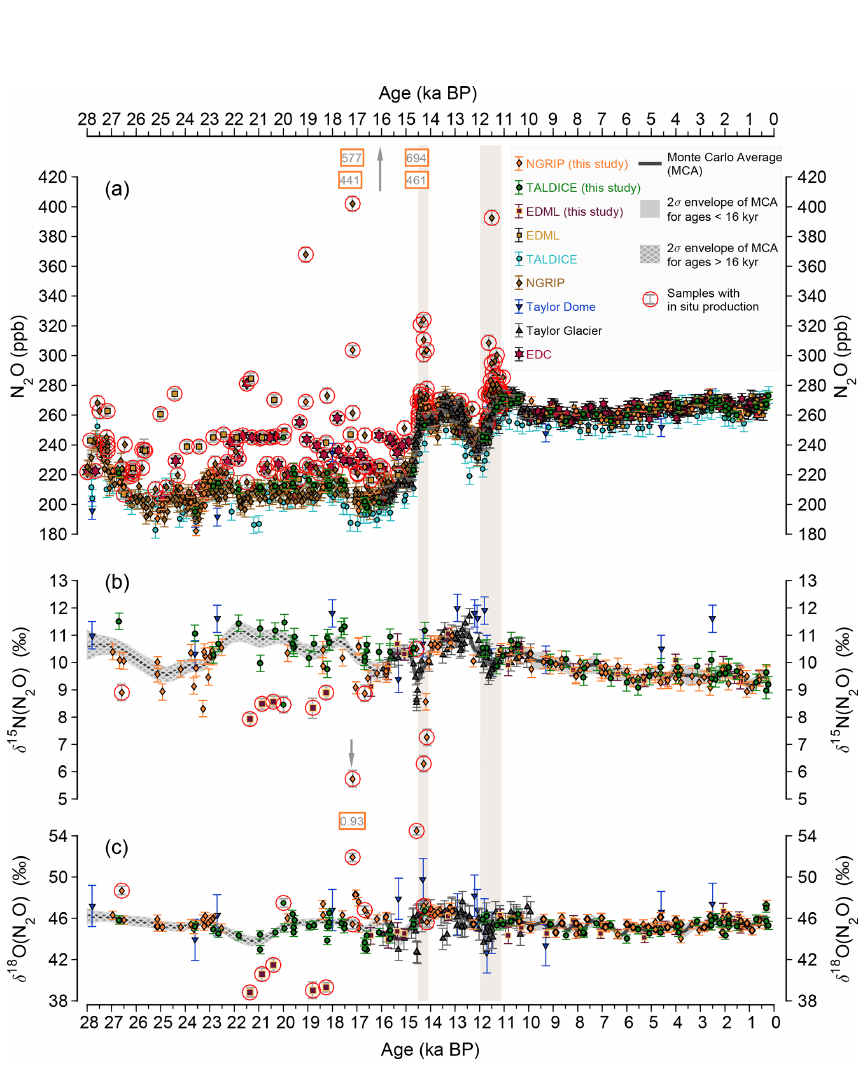
Figure 1. Compilation of new and published N 2 O records over the last 28kyr including identified artifacts due to in situ production of N 2 O. (a) N 2 O concentration from this study and published records (Sowers et al., 2003; Bernard et al., 2006; Flückiger et al., 2002; MacFarling Meure et al., 2006; Park et al., 2012; Schilt et al., 2010b; Schmitt et al., 2014) (b) δ 15 N(N 2 O) and (c) δ 18 O(N 2 O) from this study and published records (Sowers et al., 2003; Bernard et al., 2006; Park et al., 2012; Schmitt et al., 2014; Schilt et al., 2014). The solid lines in (a) – (c) represent Monte Carlo average smoothing splines with a cutoff period of 2000 years prior to 16kaBP and 700 years afterwards. The grey shaded envelopes ( ± 2 σ ) represent the Monte Carlo based uncertainties of the splines. Samples identified to be subject to in situ formation are indicated by red circles; extreme values outside the plotting range are indicated by arrows and provided in small orange